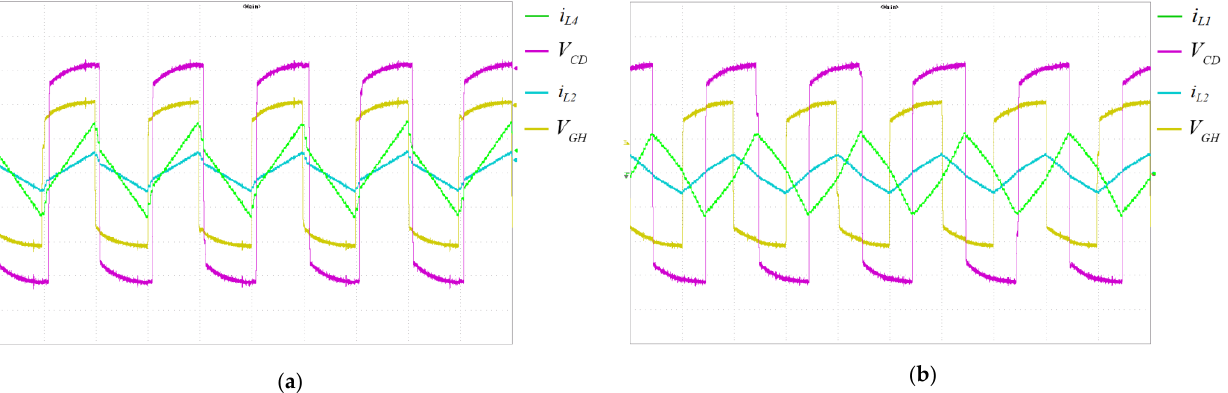
Figure 15. Voltage and current waveforms with the SPS modulation technique at f sw = 50 kHz, i L2 (cyan, 100 A/div), i L4 (green, 100 A/div), V GH (yellow, 200 V/div), and V CD (magenta, 200 V/div): ( a ) P 1 = P 2 = P 3 = P 4 = 50 kW, ( b ) P 2 = P 3 = 33.3 kW, P 4 = 100 kW. Time scale = 10 μ s/div.